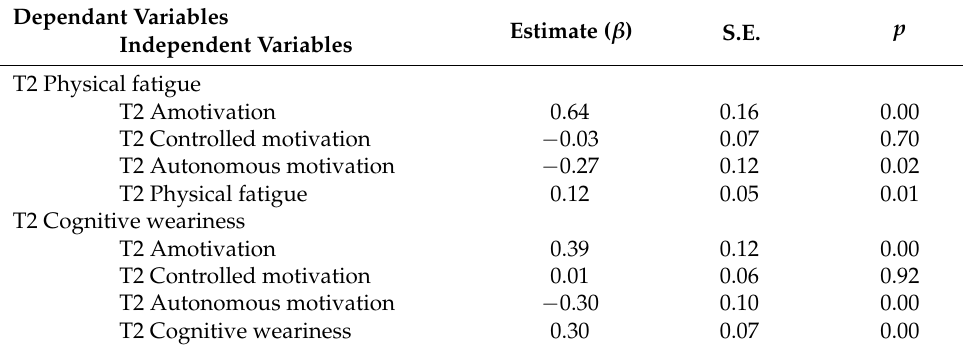
Table 4. Standardized Estimates for the Structural Model: Self-determined Motivation. Burnout. and